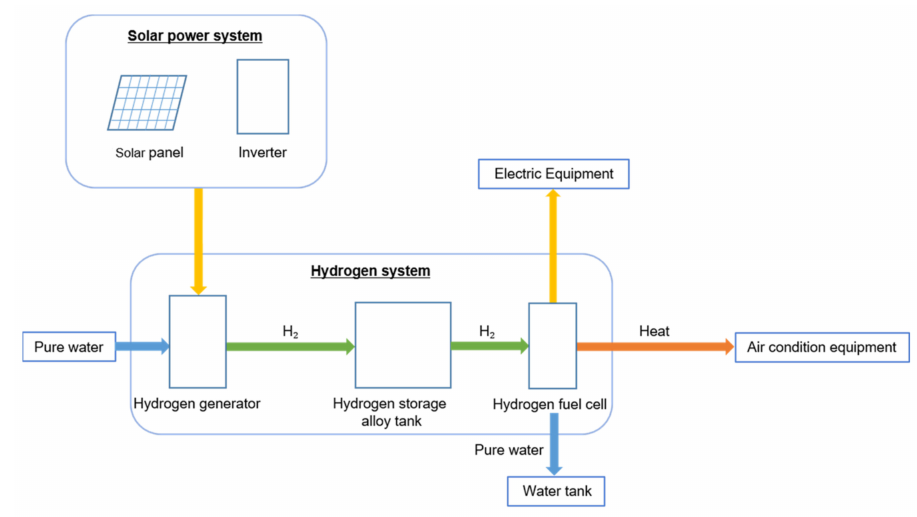
Figure 9. The hydrogen production system using surplus electricity and the directions of its